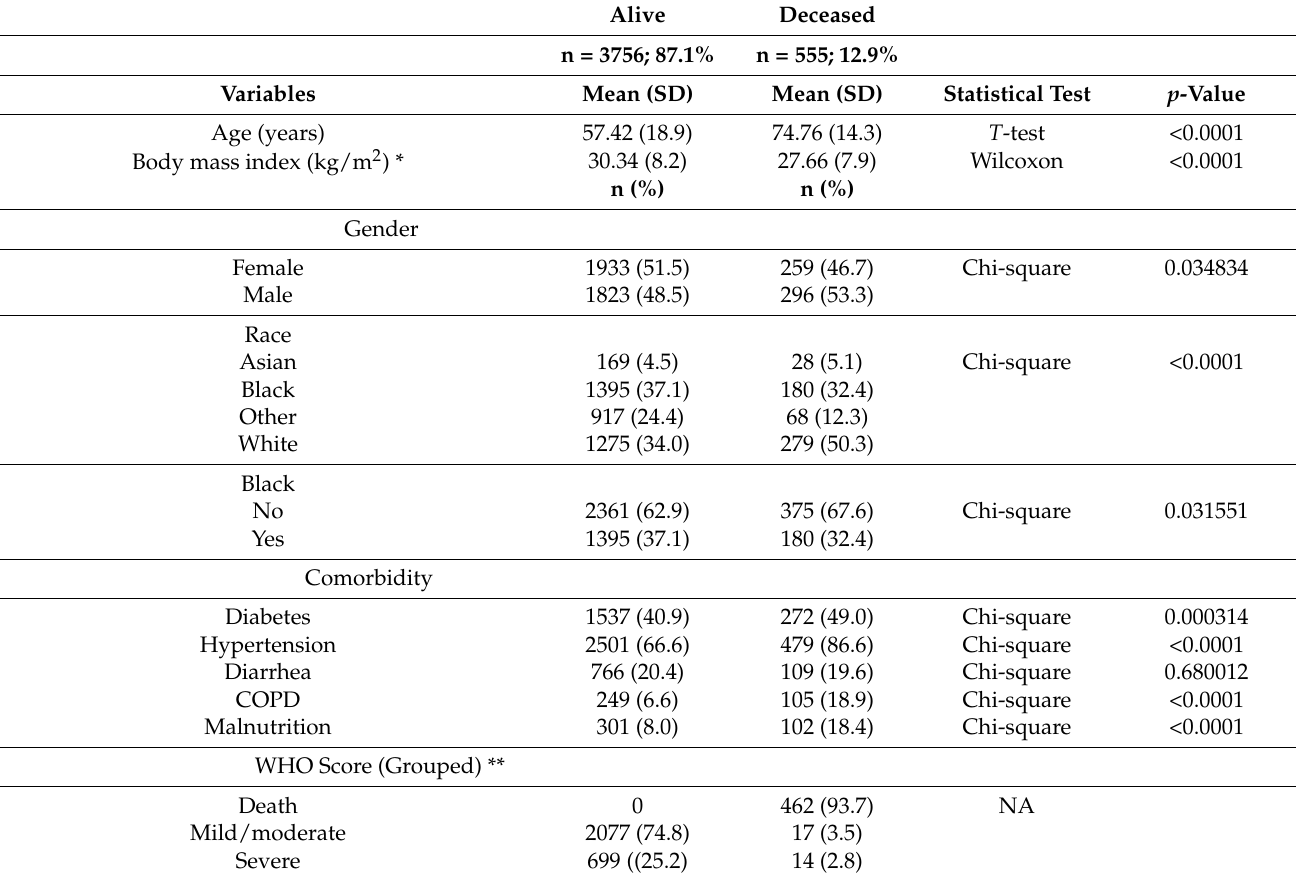
Table 2. Characteristics of COVID-19 inpatients based on mortality status, alive or deceased,